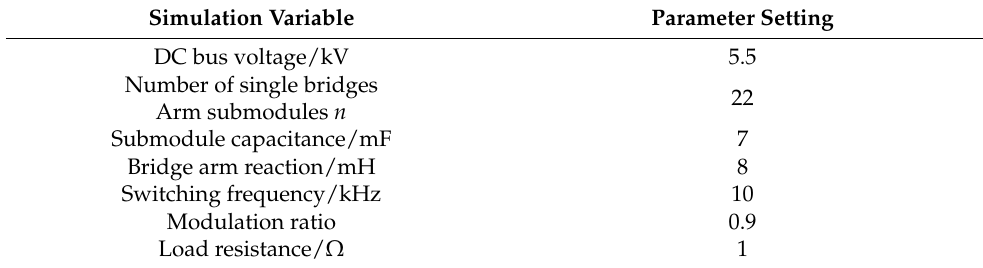
Table 1. Simulation parameters.